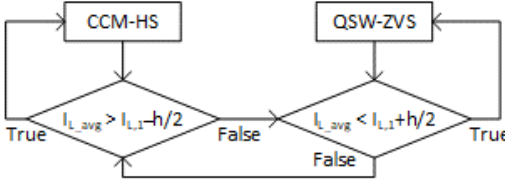
Figure 7. Flow chart explaining selection among modes.